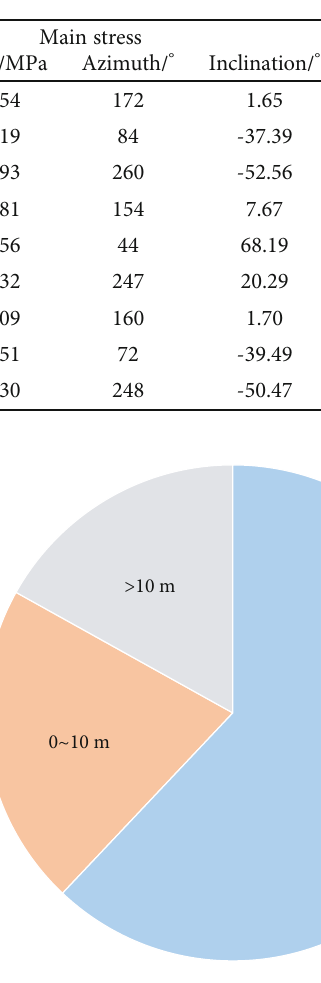
Figure 3: Statistics of impact scope of working